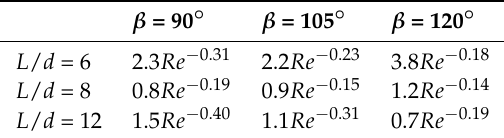
Figure 1. Parameters of FSGs [14]. Table 2. Correlation for λ calculation considering different FSGs